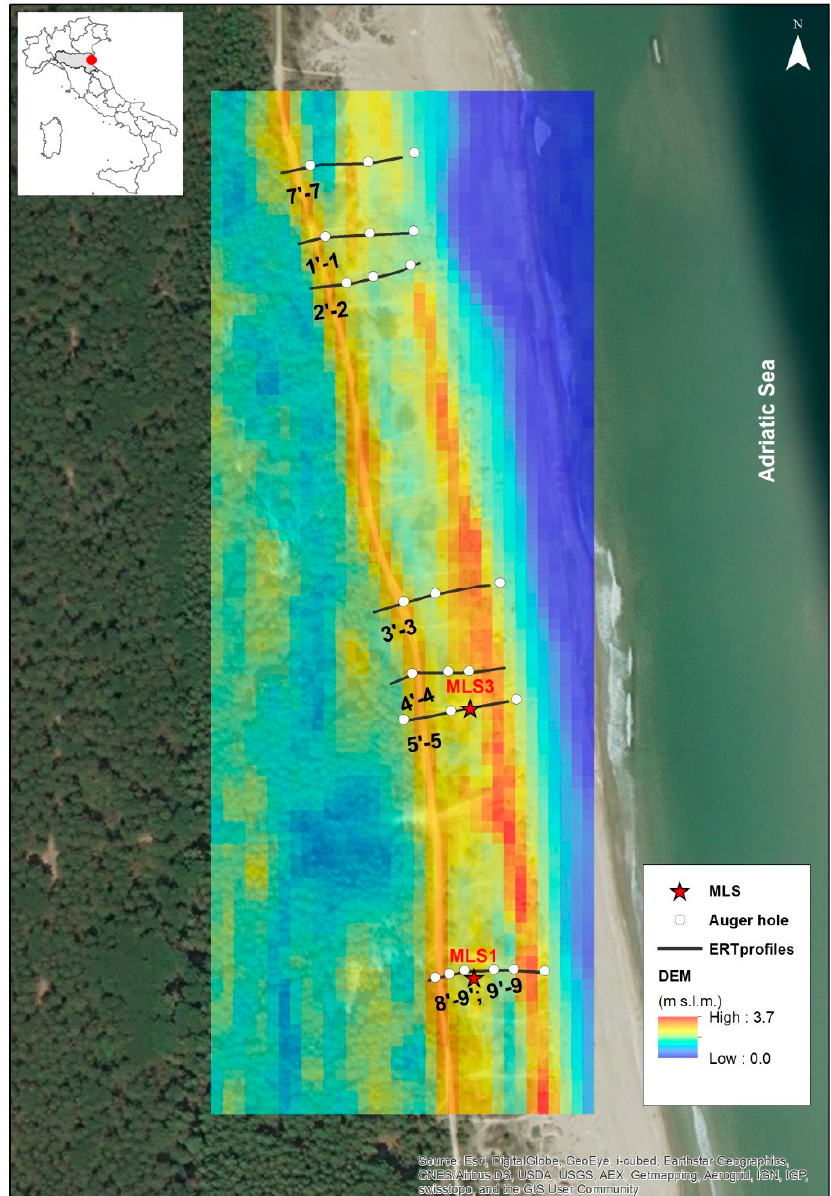
Figure 1. Study area location. The digital elevation model (DEM), electrical resistivity tomography (ERT) profiles, multi-level sampler piezometers (MLSs), and auger hole locations are also shown. The pine forest extends parallel to the coast for 150 ha. Due to a low topography (average elevation is about 0.3–0.5 m mean sea level (m.s.l.)), a high rate of natural and anthropic subsidence